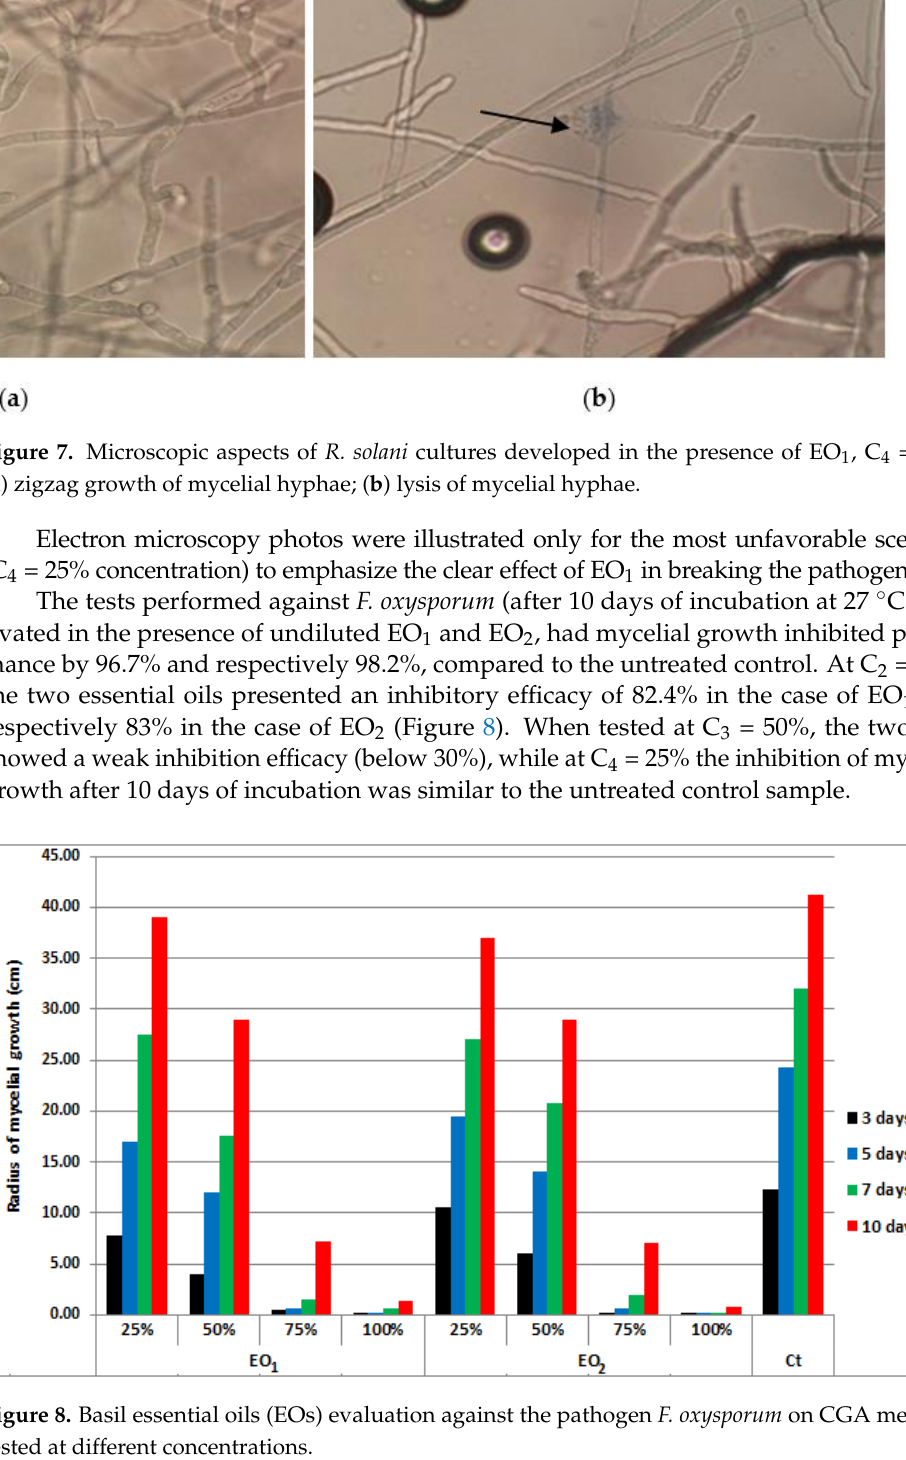
Figure 6. Basil essential oils (EOs) evaluation against the pathogen R. solani on CGA medium, tested at different concentrations.